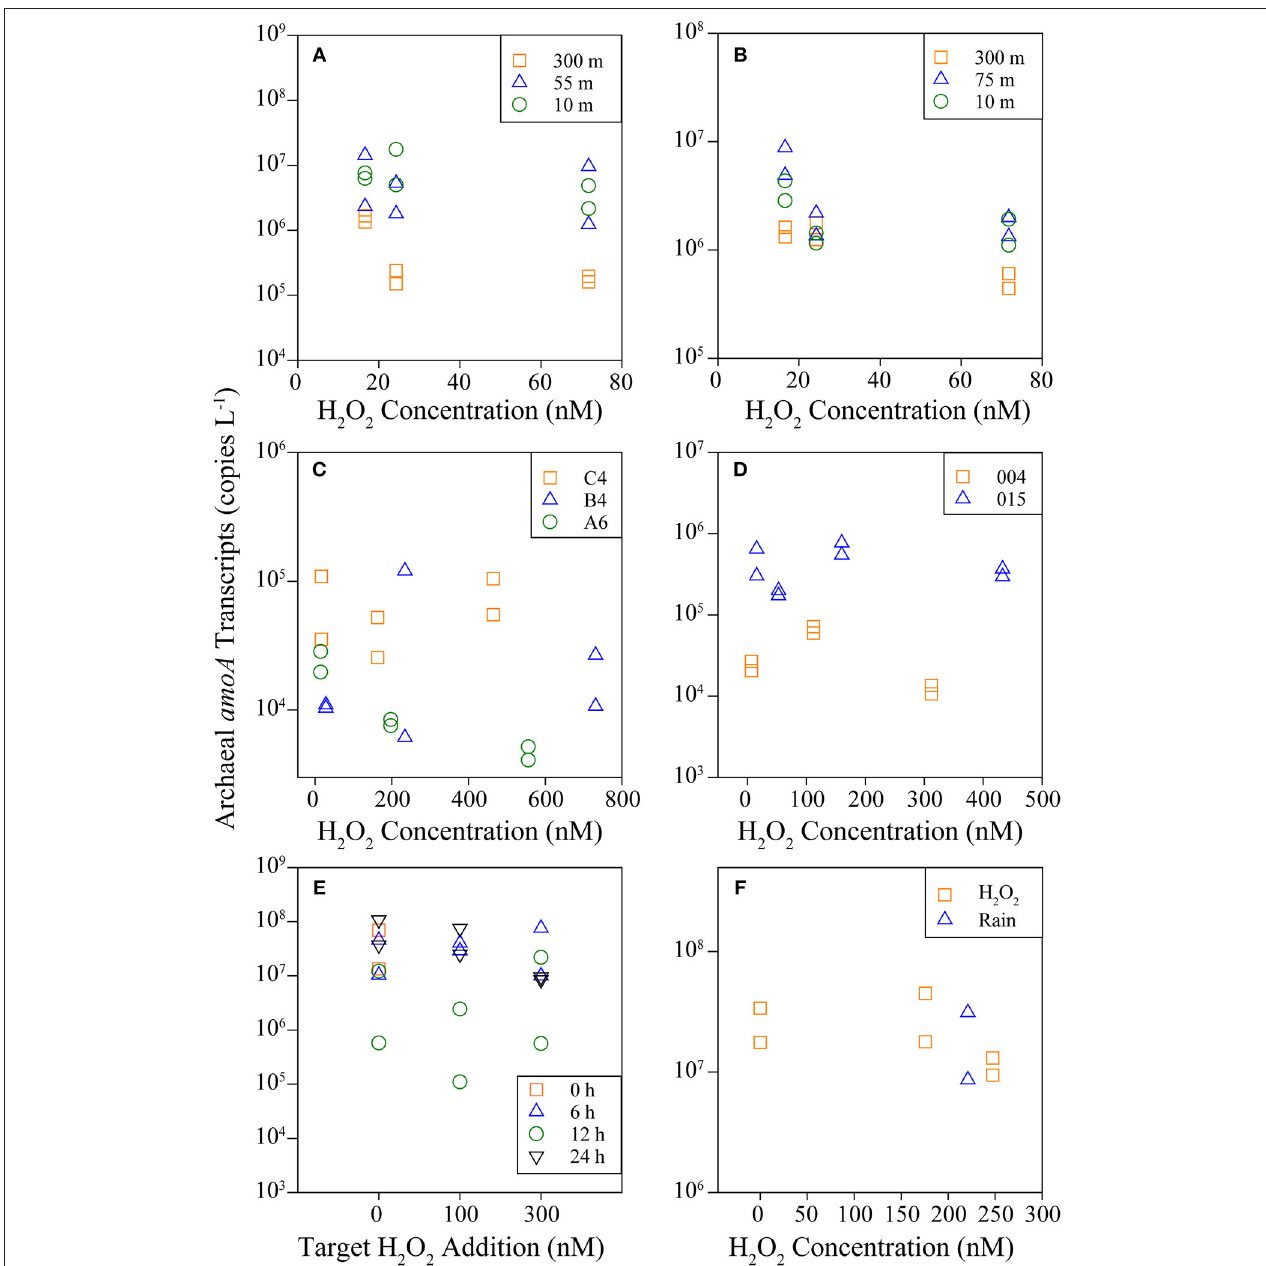
FIGURE 5 | Archaeal amoA transcripts quantified by RT-qPCR using RNA collected from the Southern Ocean (A,B; symbols represent sample depth), Gulf of Mexico and Gulf of Alaska (C,D , respectively; symbols represent station sampled), and Marsh Landing in 2011 (E) and 2012 (F) . Symbols indicate H 2 O 2 origin, either chemical H 2 O 2 or from